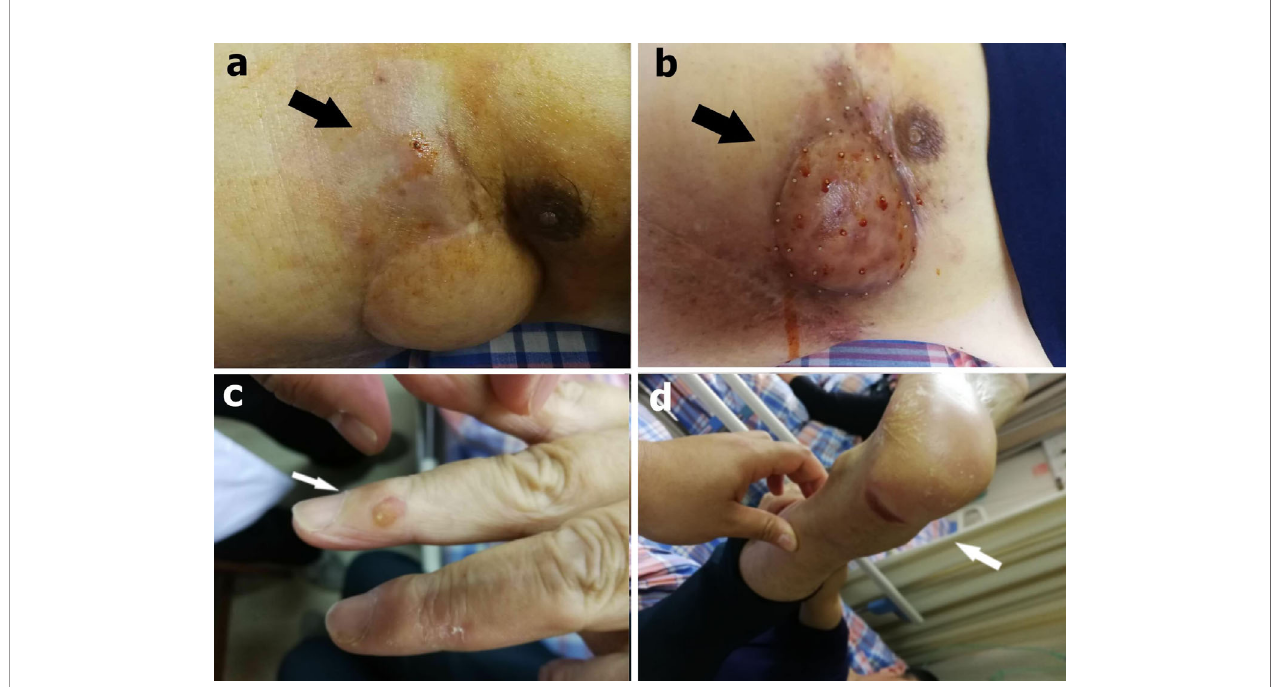
FIGURE 3 | (A) During the fi rst apitherapy session, the patient was stung by only one bee and observed in a ward for 2 h (black arrow). (B) After 9 weeks, the dose had gradually increased to 50 bee stings each time (black arrow). (C) A fi nger ulcer (white arrow) and (D) a heel ulcer were side effects of apatinib (white